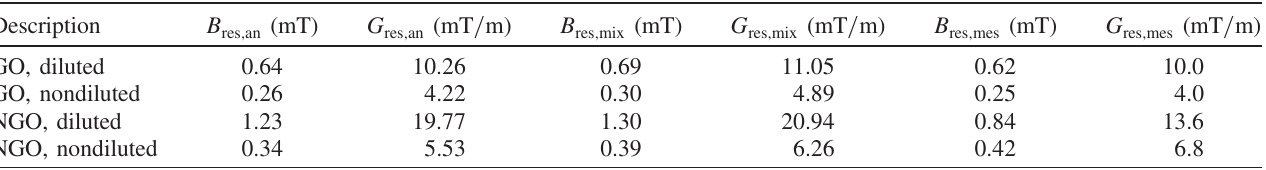
TABLE X. Remanent pole field B diluted NGO (#4)